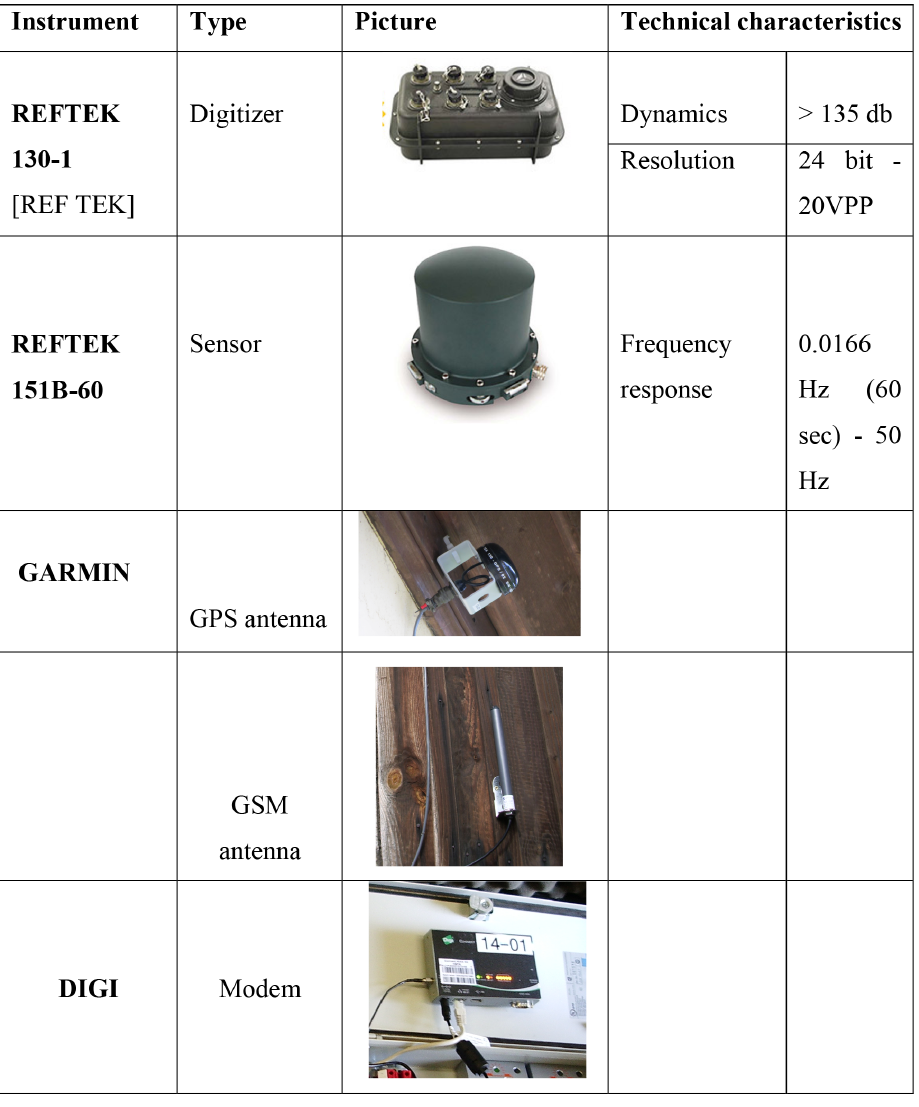
Figure 3. From top to bottom: Reftek digitizer 130-01; seismic sensor Reftek 151-60; GPS Garmin antenna; GSM antenna; modem. All of them were used during the acquisition